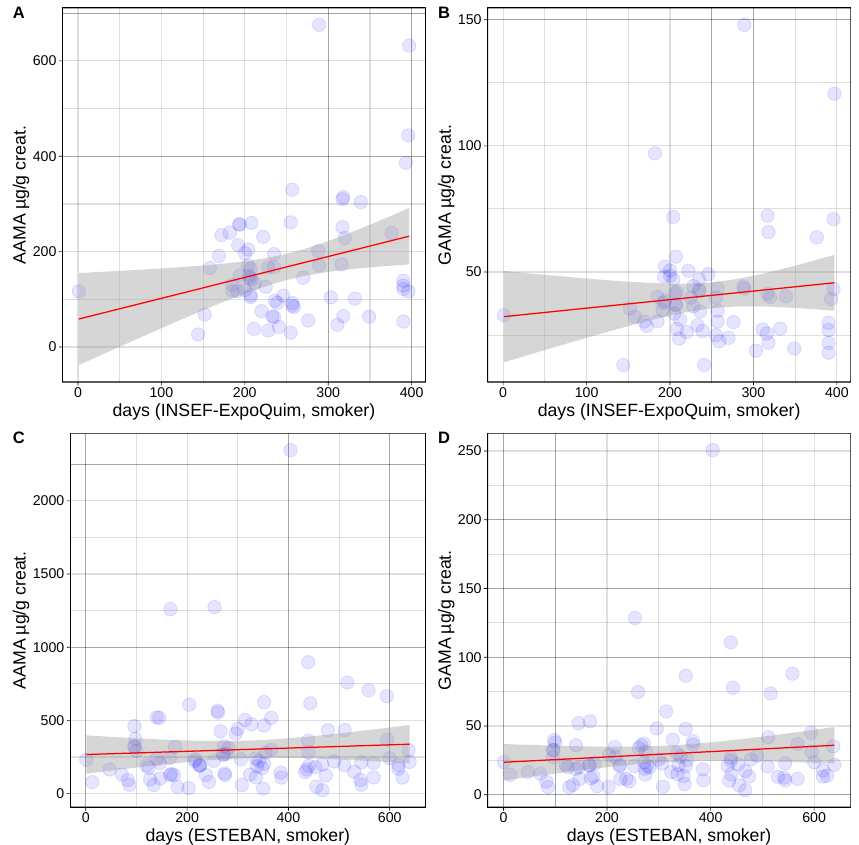
Figure A1. Time-trend of AAMA ( A , C ) and GAMA ( B , D ) urine concentrations in µg/g creatinine (per sampling day, 0 = first day of sampling) in individual data (smoker) from HBM4EU-aligned studies from Portugal (INSEF-ExpoQuim, top) and France (ESTEBAN, bottom). Linear fit in red, gray = 95% . Trends were found to be not significant in statistical analysis. Table A1. Estimated slope (s) and statistical significance of a multiple linear regression for AAMA and GAMA in µg/g creatinine (after normalization by logarithmic transformation using natural logarithm, ln) and in function of the sampling day in children. ***: p < 0.001; ns: not significant. Study AAMA (ln(µg/g Creatinine)/Day) GAMA (ln(µg/g